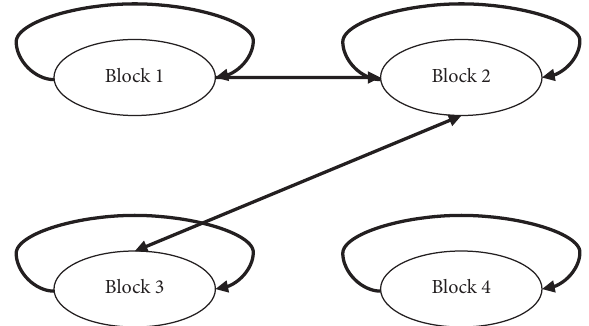
Figure 3: Relationship between China’s four digital financial inclusion development